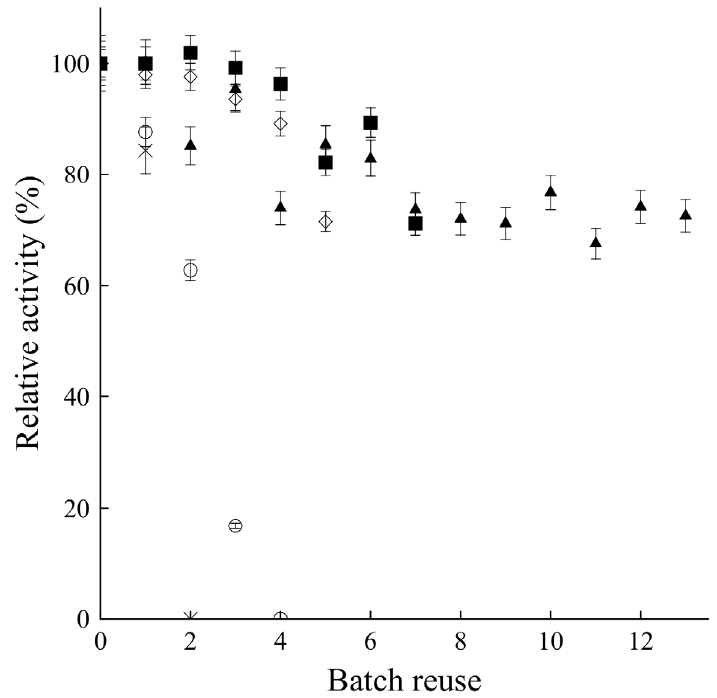
Figure 3. Operational stability of CALB during repeated batches on butyl acetate synthesis. (  ) MCI-CALB under optimal condition I; (  )MCI-CALB under optimal Condition II; (  ) MCI-CALB under mechanical stirring conditions; (  ) Novozym 435 under ultrasound conditions; (  ) Novozym 435 under mechanical stirring